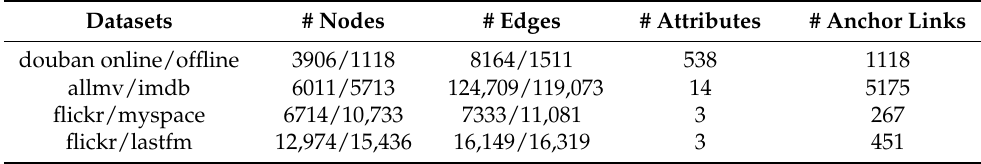
Table 1. Statistics of the datasets. Here, the symbol # means “number of”.